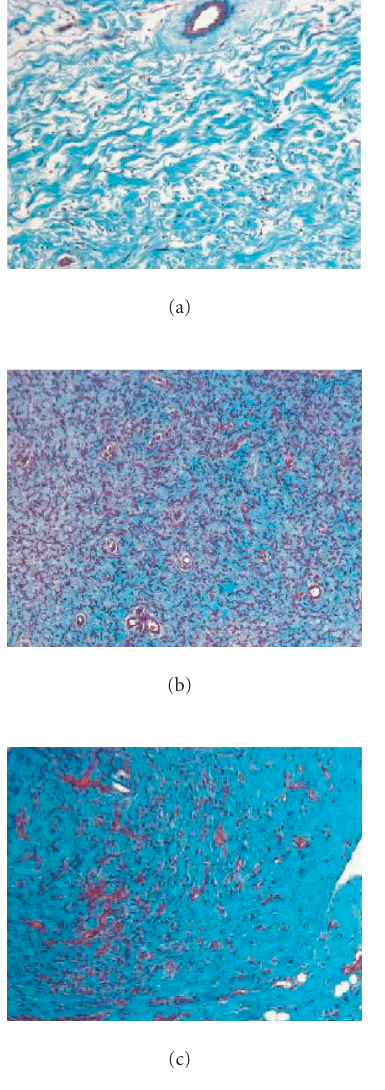
Figure 3. Localization of S-100 in human neurofibroma trans- planted into SCID mouse. Tissue samples from original tumors and from human neurofibroma xenografts were snap-frozen, cryo-sectioned, stained with rabbit antibodies specific for hu- man S-100 and studied by immunofluorescence microscopy. Fluorescence is localized in Schwann cells in the original tumor (a) and in tumor xenografts recovered 6 weeks after implan- tation from nontreated animal (b) and from animal receiving pirfenidone (c). The presence of S-100 in the xenografts con- firms persistence of Schwann cells in implanted tumors. Positiv- ity for S-100 was not changed by treatment with pirfenidone for 6